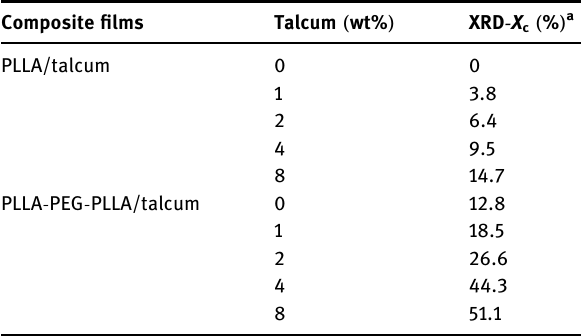
Table 2: XRD - X c of PLLA/talcum and PLLA - PEG - PLLA/talcum fi lms